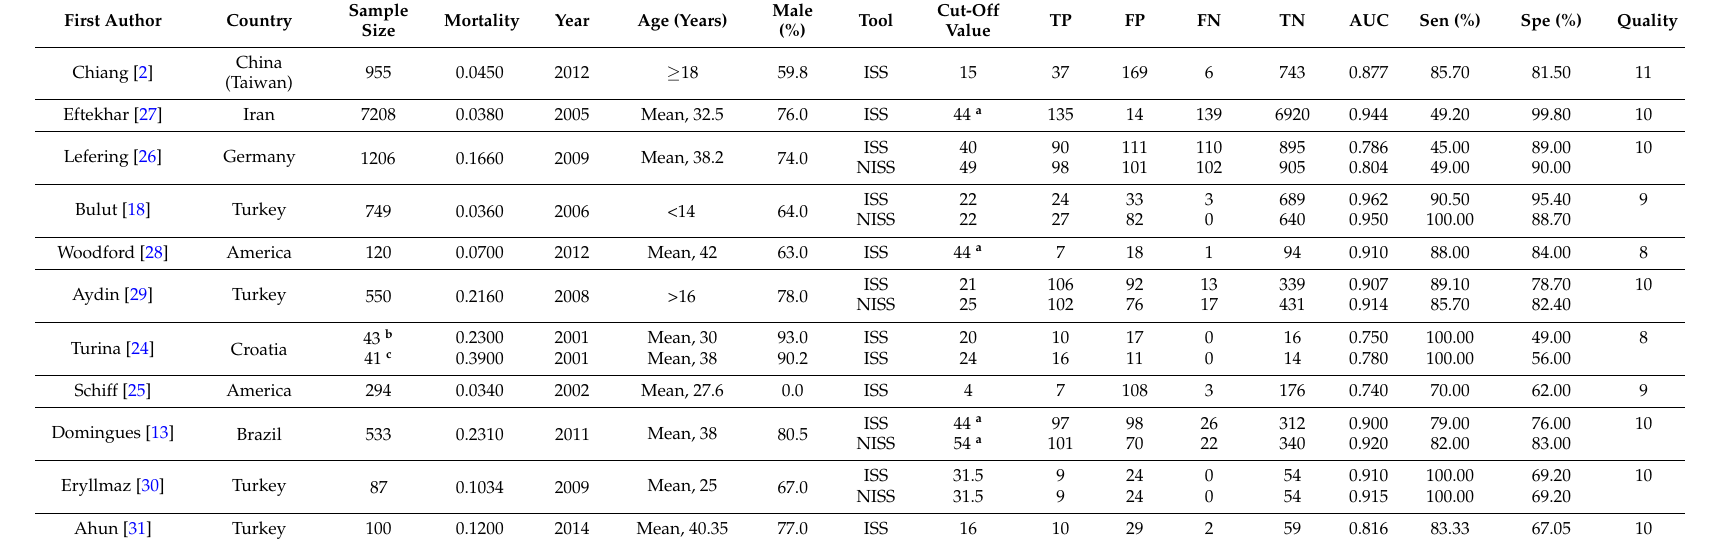
Table 1. General characteristics of studies that assessed the performance of the ISS or NISS for predicting